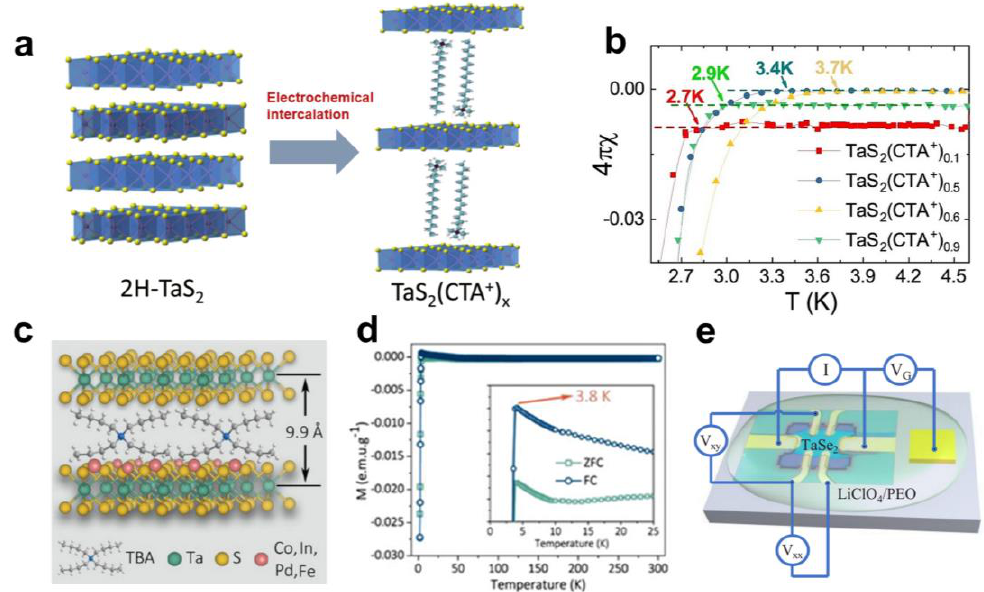
Figure 1. ( a ) Schematic of the crystal structure of 2H-TaS 2 before and after electrochemical interca- lation. Reproduced with permission from Ref. [25]. Copyright 2018, IOP Publishing Ltd. (Bristol, UK). ( b ) Temperature dependence of the magnetic susceptibility of TaS 2 (CTA + ) x . Reproduced